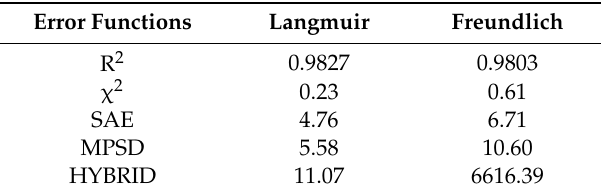
Table 3. Error function analysis for linear isotherm fitness.